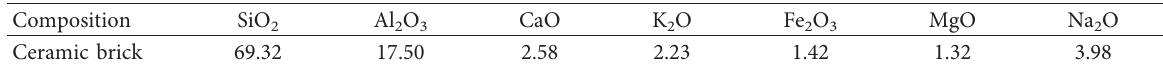
Table 2: Chemical composition of ceramic permeable brick.